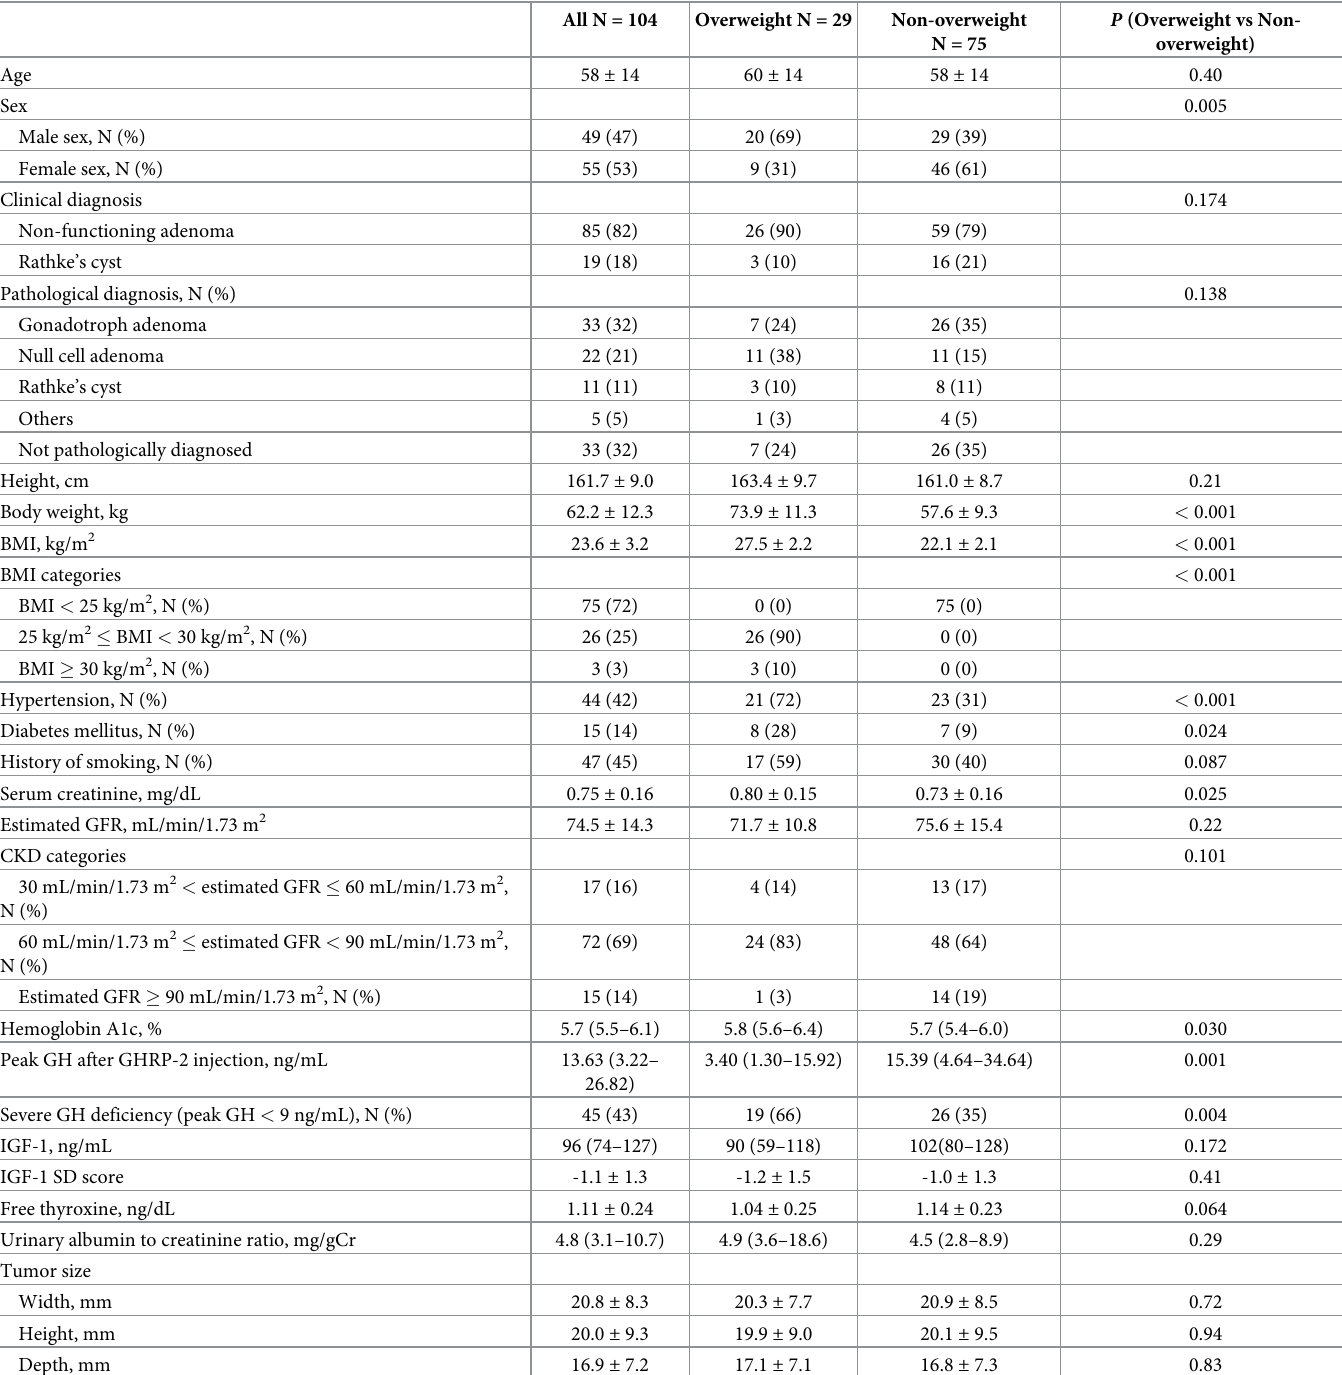
Table 1. Background